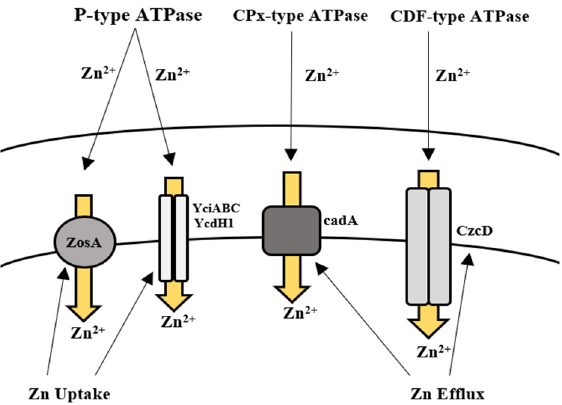
Figure 2. Uptake and efflux mechanism of Bacillus spp. for the regulation of